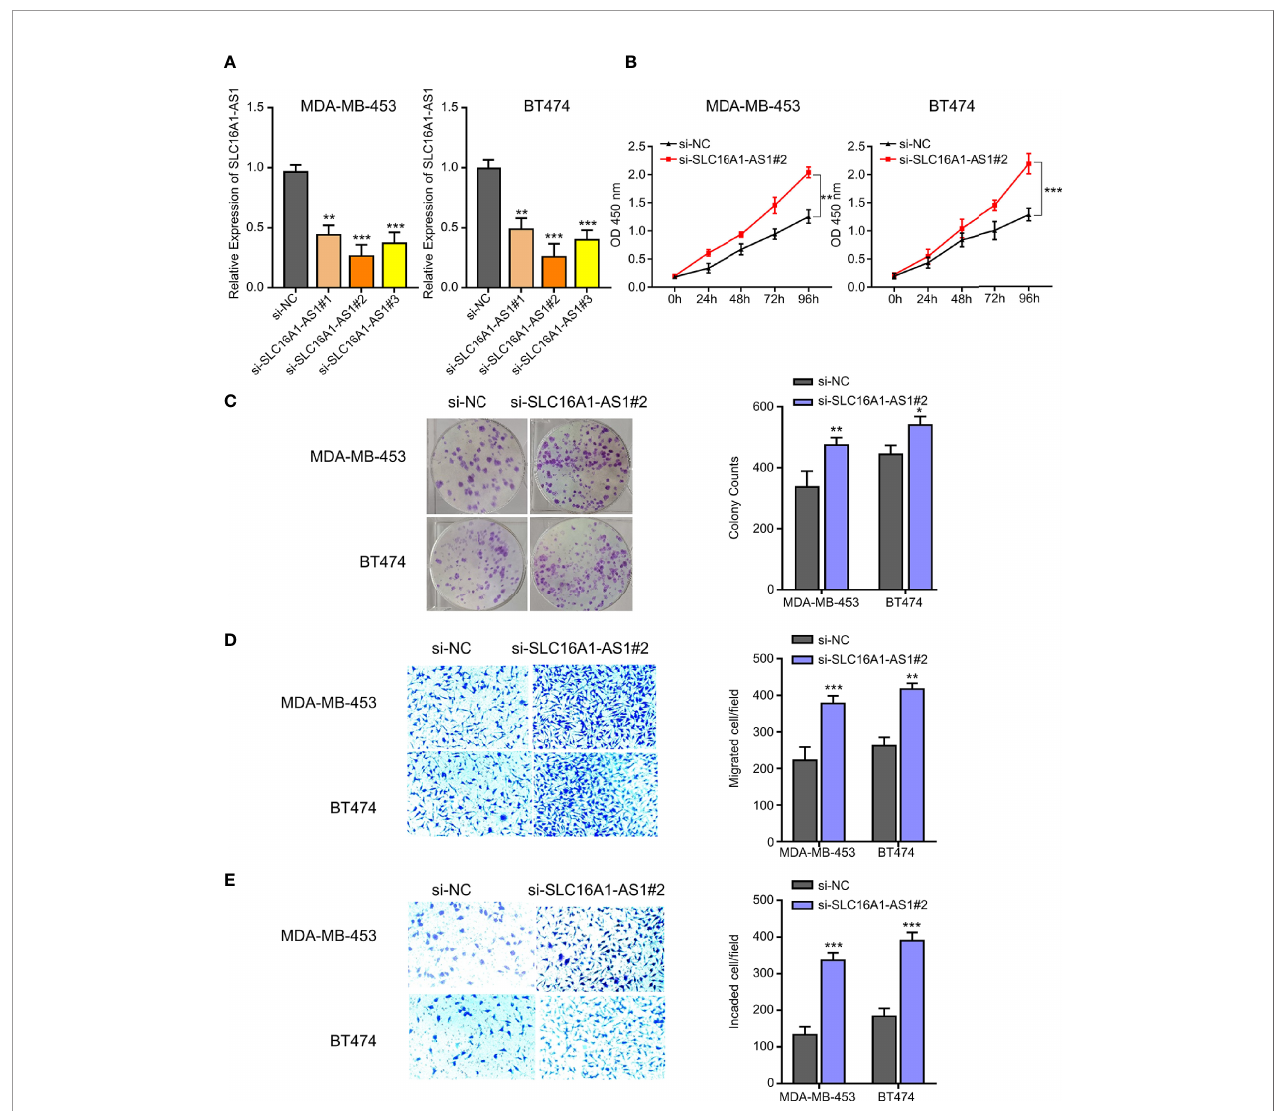
FIGURE 3 | Overexpression of SLC16A1-AS1 inhibits the viability, colony formation, invasion, and migration of BC cells. To explore the functions of SLC16A1-AS1 in BC progression, SLC16A1-AS1 was overexpressed in MDA-MB-231 and MCF7 cells. After being con fi rmed that SLC16A1-AS1 was effectively overexpressed in both MDA- MB-231 and MCF7 cells (A) ( p < 0.001), the following behaviors were compared between SLC16A1-AS1 overexpressed (SLC16A1-AS1) and the negative control (NC) MCF7 and MDA-MB-231 cells: cell viability (B) , colony formation (C) , cell migration (D) , and cell invasiveness (E) . * p < 0.05, ** p < 0.01, *** p <